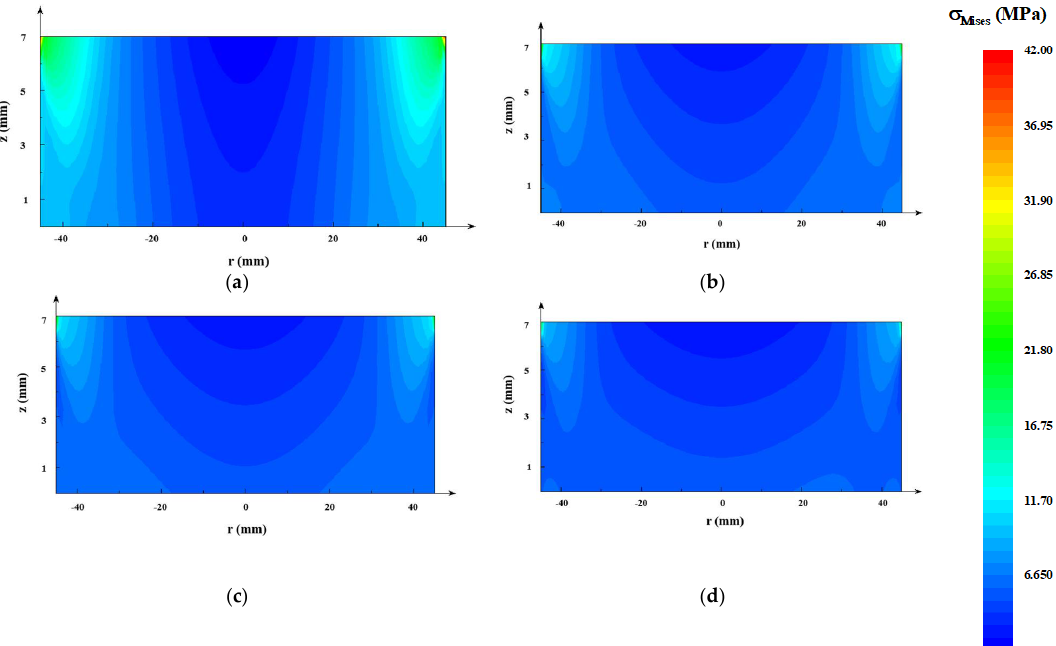
Figure 7. Thermal stress distributions of the AlN seed in crucibles with different designs: ( a ) original design; ( b ) A design; ( c ) B design; ( d ) C design.